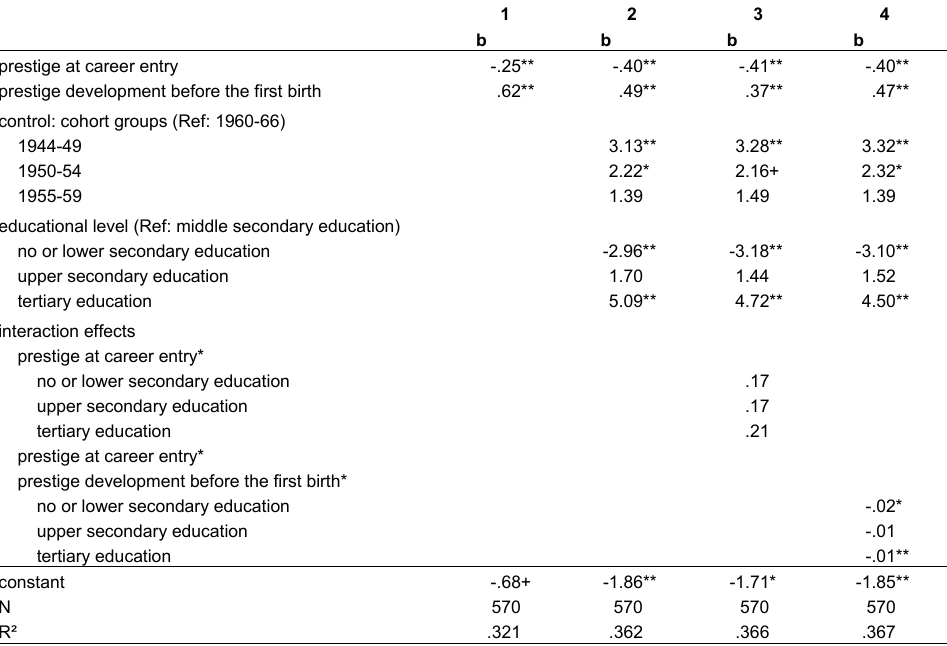
Table 5 : impact of previous prestige measures and education on prestige at age 45